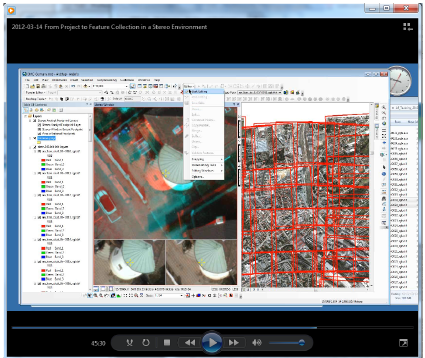
Figure 13: Webinar demonstrating use of Stereo Analyst for ArcGIS http://www.erdas.com/Resources/webinars/ArchivedWebinars.aspx